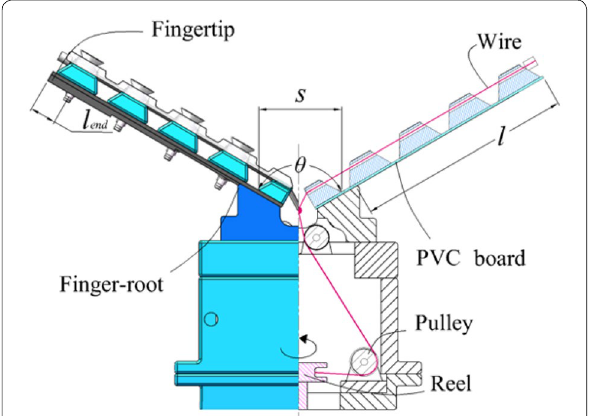
Figure 1 CAD model and schematic diagram of the STU